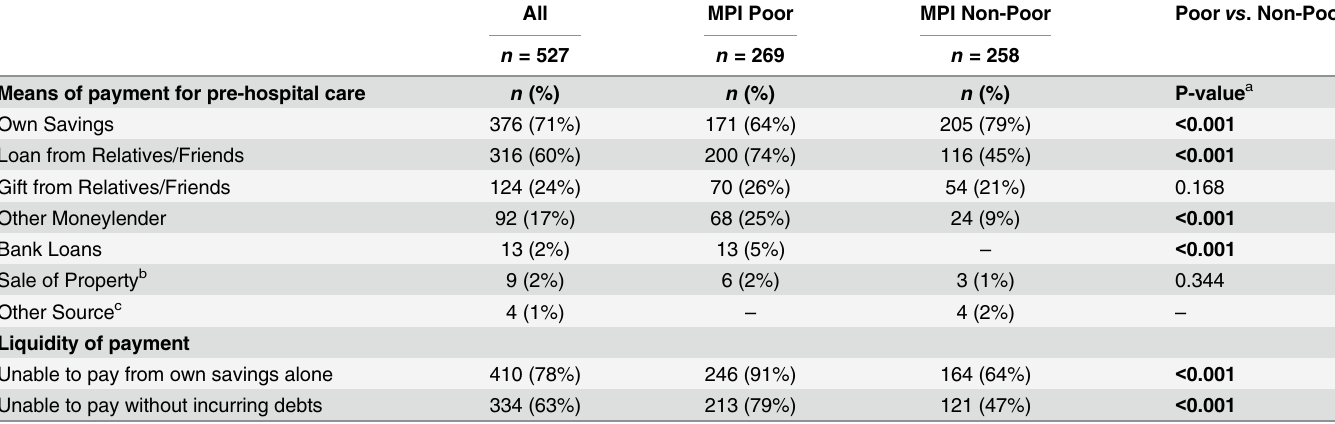
Table 8. Sources of payment for expenses arising from illness before arrival at the referral